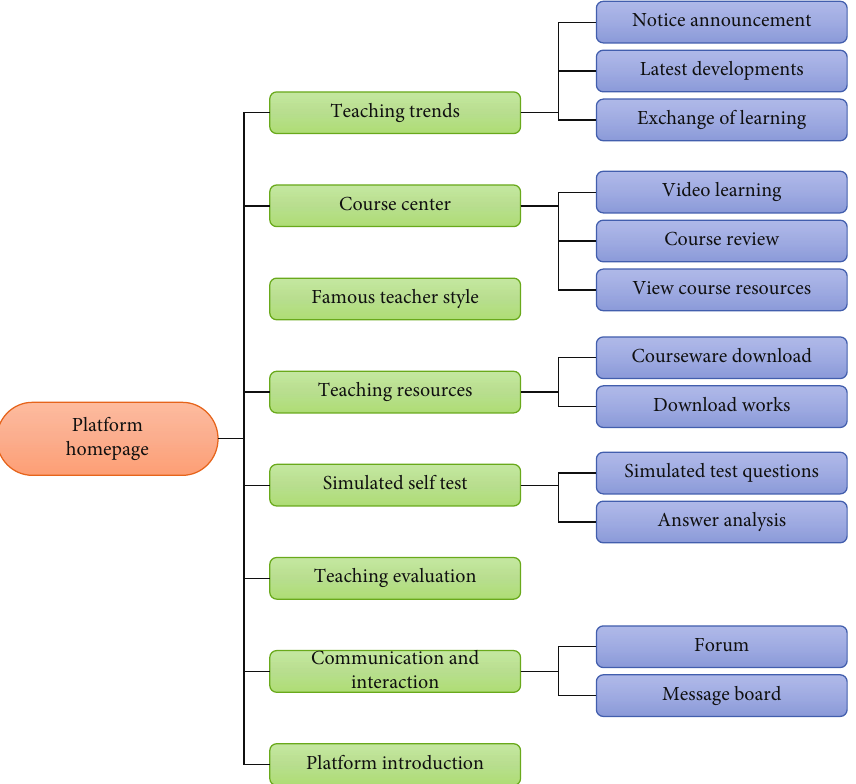
Figure 11: Platform function structure